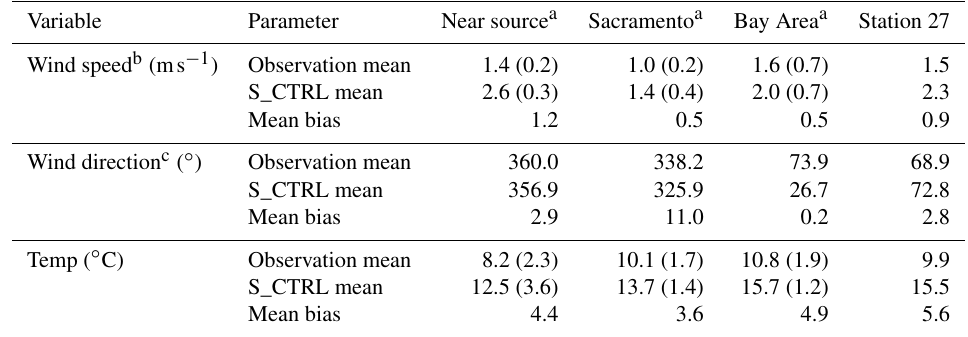
Table 2. Summary of meteorological model performance metrics for the simulation duration. Variable